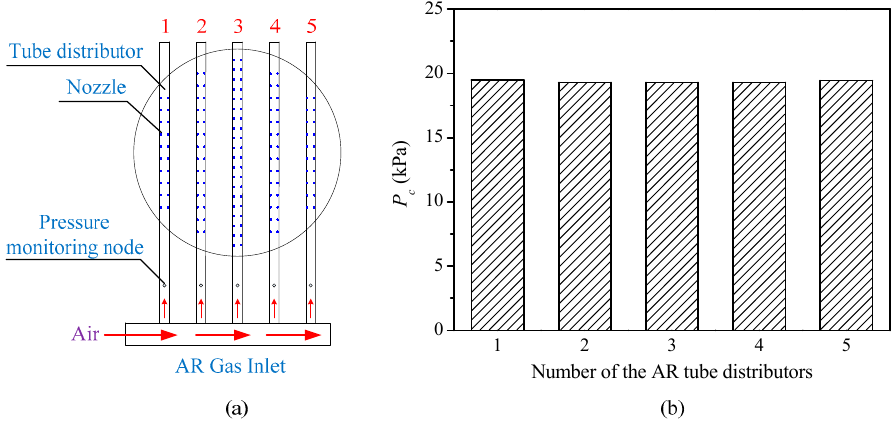
Figure 5. Pressure profiles of the parallel AR tube distributors under the reference condition: ( a ) schematic of the AR tube distributors, and ( b ) pressure profiles.